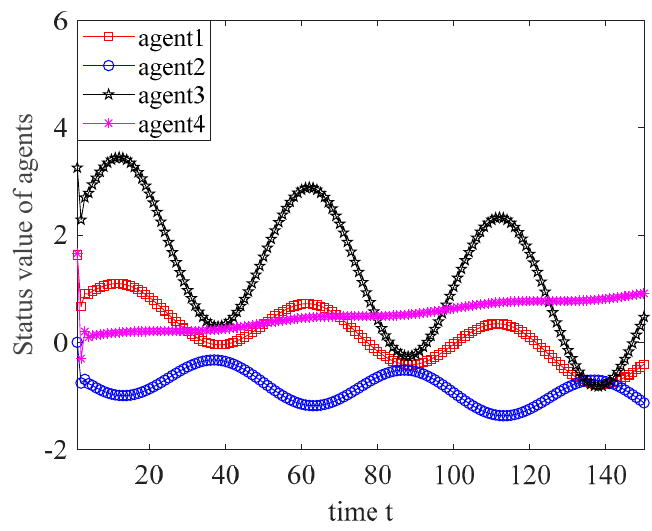
Figure 6. System error of multi-agent system with different packet loss rates: ( a ) 1% packet dropout,